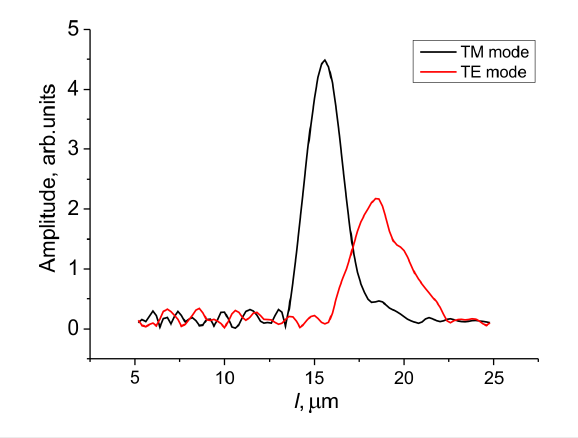
Figure 5: The Fourier transform spectra of the transmittance spectra given in Figure 4b (grating p = 300 nm, w / p = 1/2).